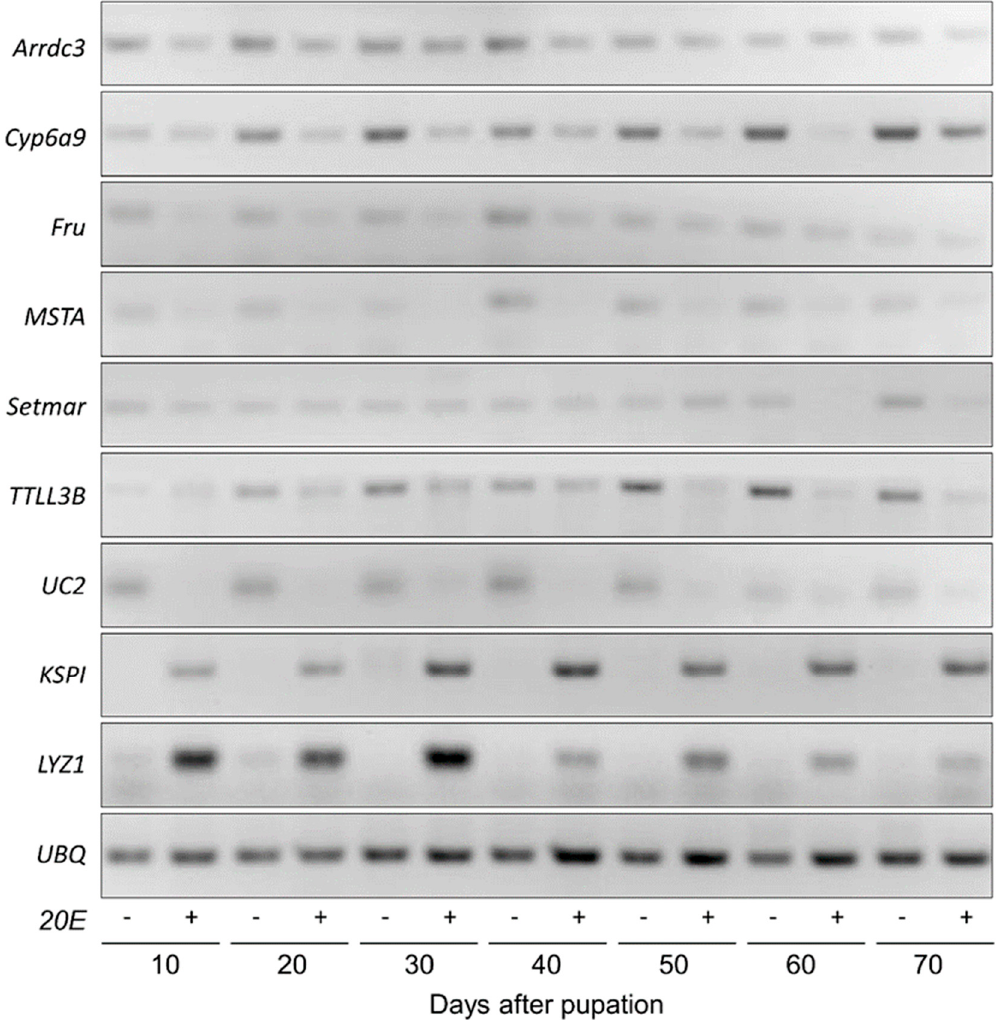
Figure 4. Relative gene expression levels between diapause-destined and non-diapause-destined B. minax pupae measured by semiquantitative PCR.